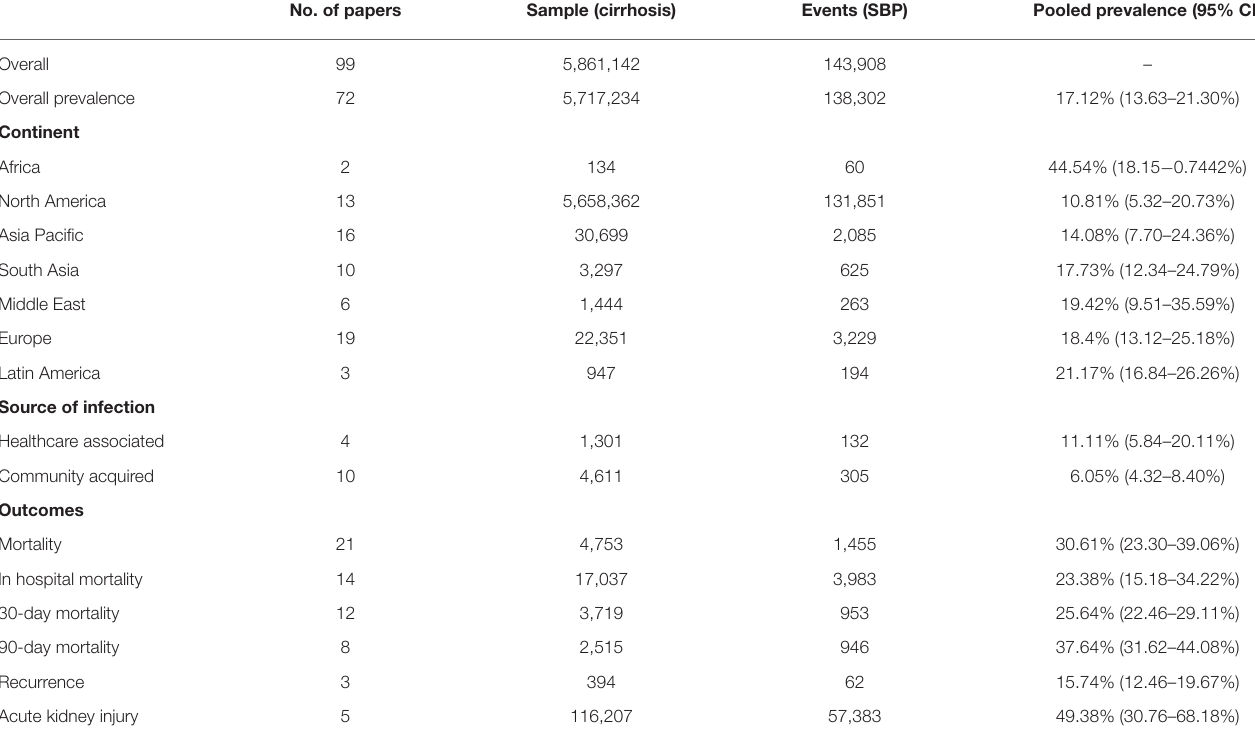
TABLE 2 | Prevalence by continent, source, and outcomes of SBP in